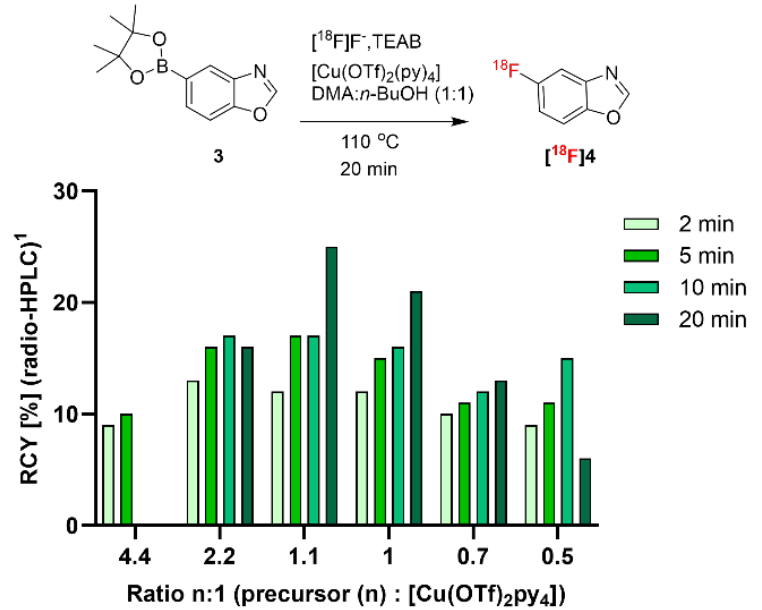
Figure 2. Optimization of radiofluorination under variation of the ratio of precursor 3 to Cu(OTf) 2 py 4 . 1 RCYs were determined by radio-high-performance liquid chromatography (radio- HPLC).